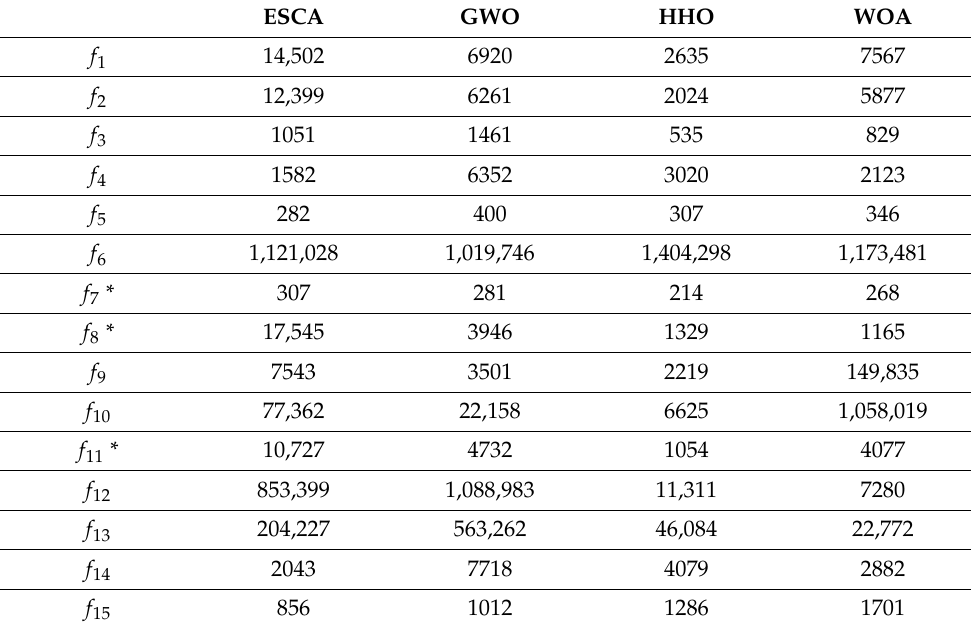
Table 17. Number of function evaluations for error <1 × 10 − 3 (* <1 × 10 2 ). ESCA